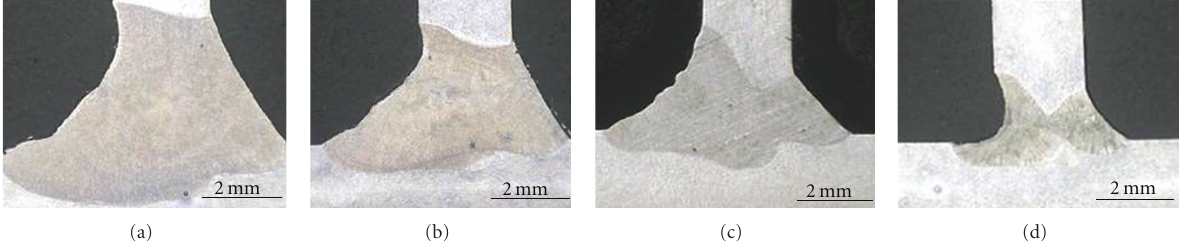
= 7 . 8kW). (a) 2m/min, (b) 2